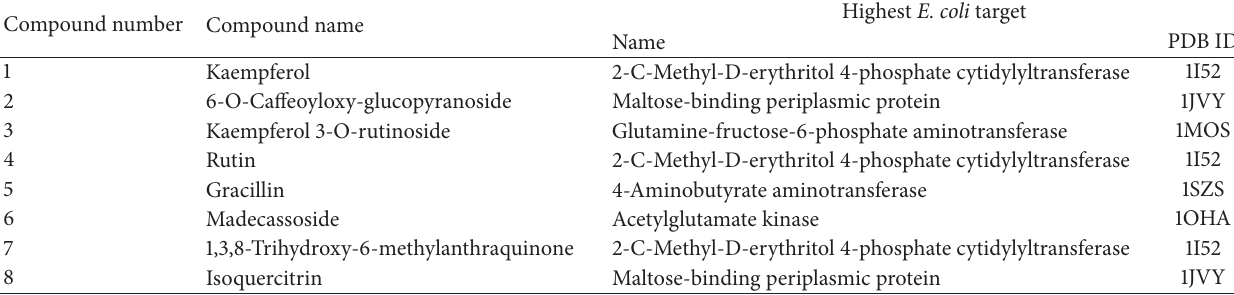
Table 4: The highest E. coli targets predicted for Sanjin Tablets compounds.